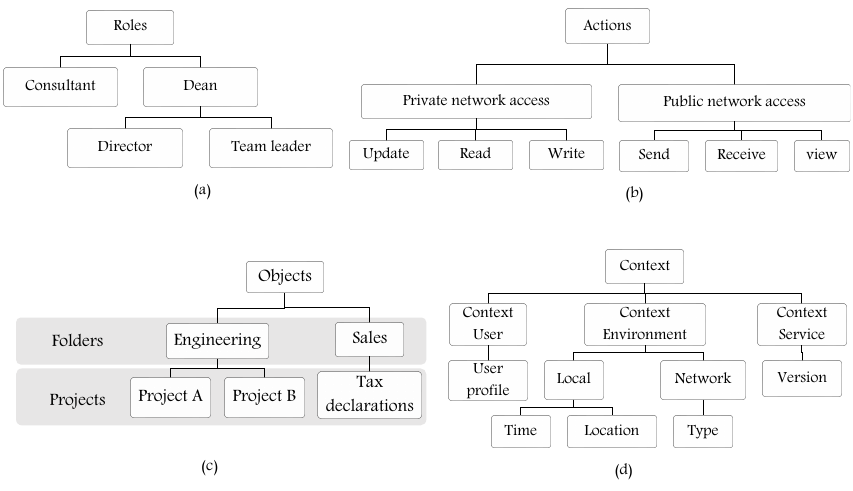
Figure 10. Examples for hierarchy of ( a ) roles, ( b ) actions, ( c ) objects, and ( d ) contexts [3].